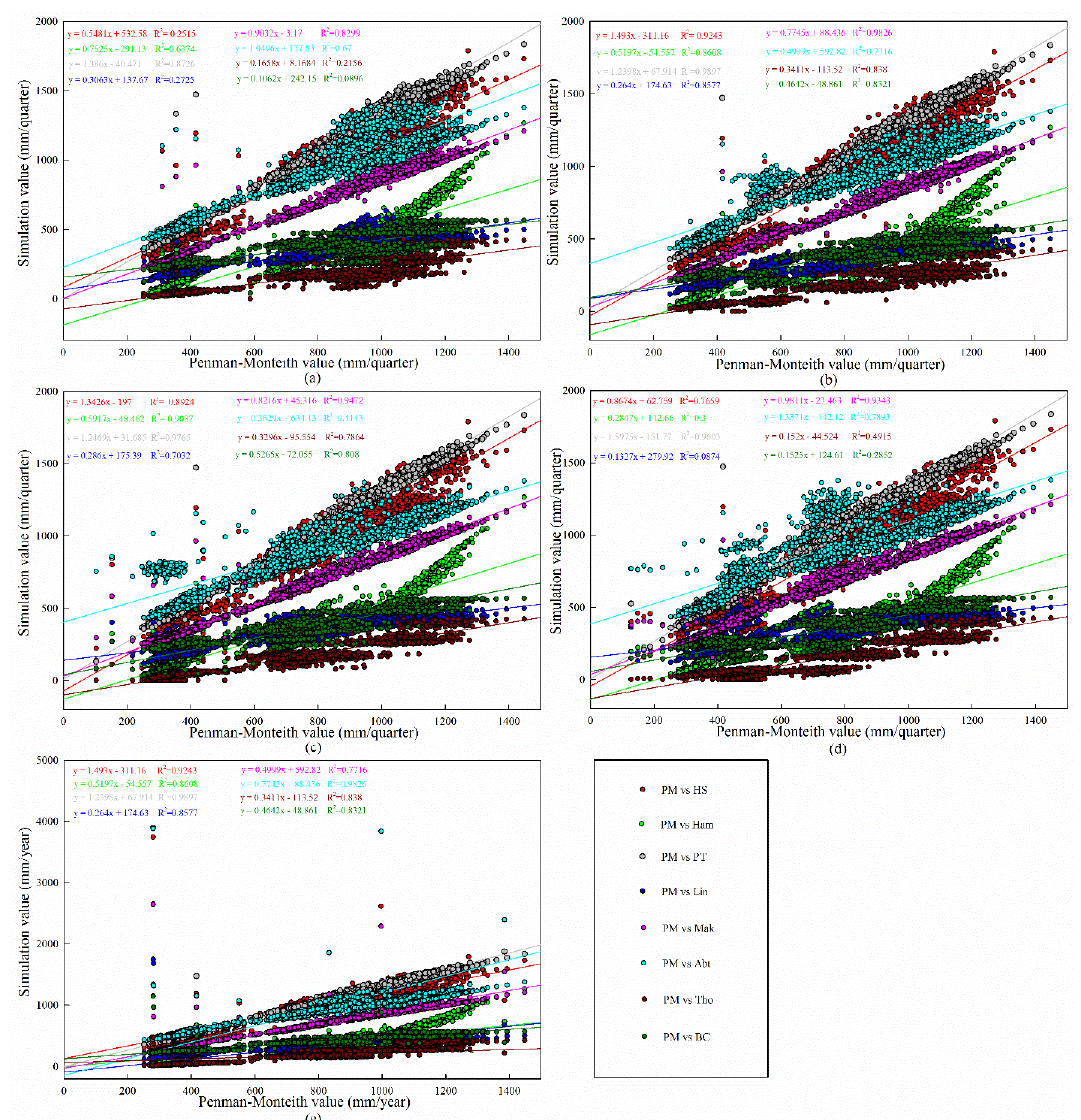
Figure 4. Linear regression of measured and simulation values in the eastern margin of the Tibetan Plateau: ( a ) spring; ( b ) summer; ( c ) autumn; ( d ) winter; and ( e ) annual.